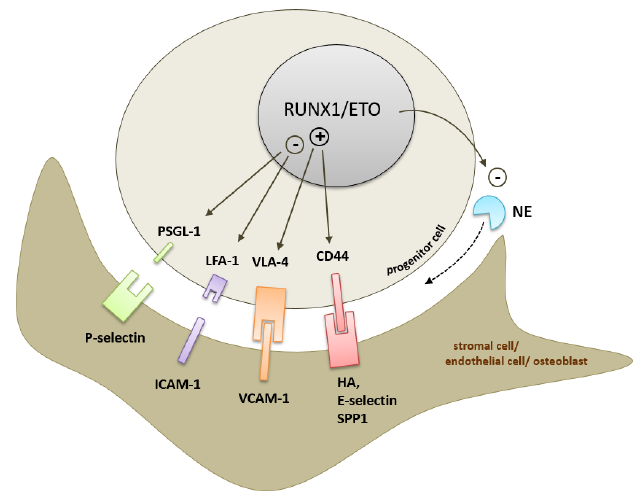
Figure 3. RUNX1/ETO-induced CAM signature within the bone marrow microenvironment. The cell adhesion molecules PSGL-1, LFA-1, CD44, and VLA-4 have been described as target genes directly regulated by RUNX1/ETO [100,104,105,107]. Neutrophil elastase (NE) has been described as a RUNX1/ETO-repressed target gene [114].